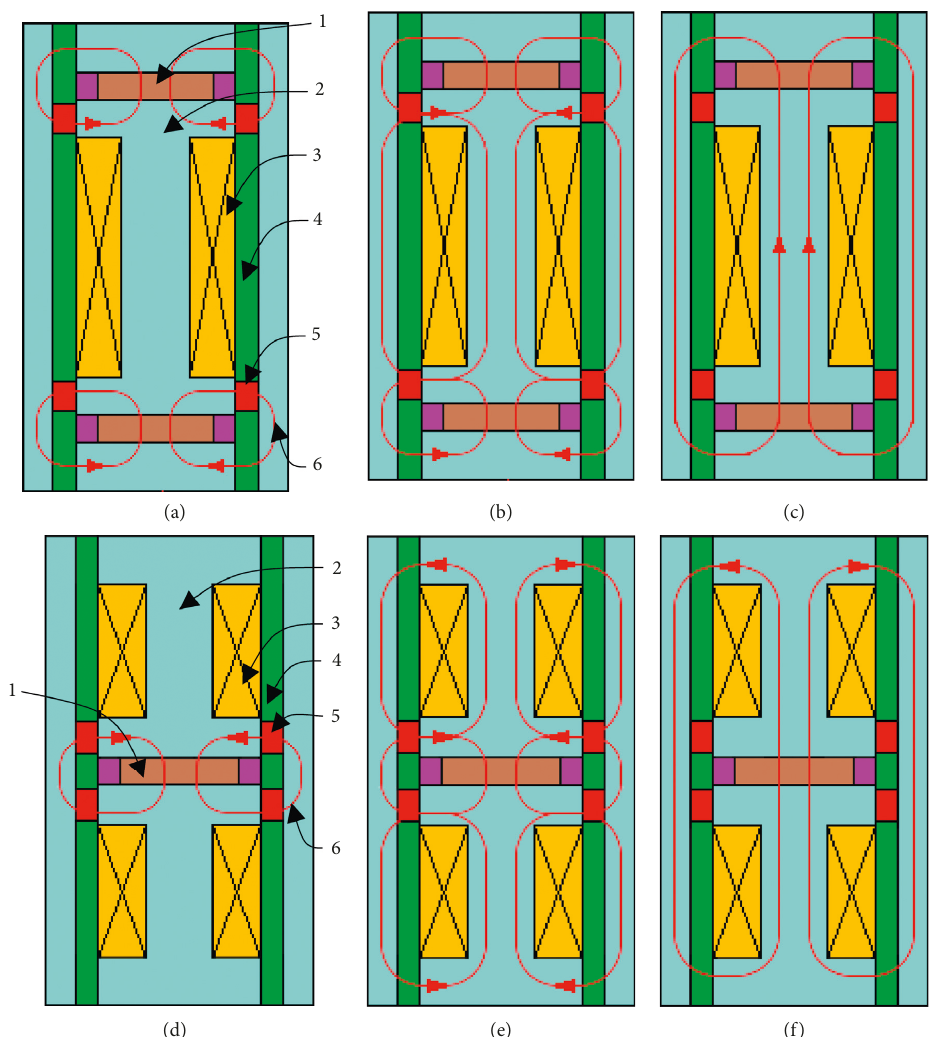
Figure 7: Single-coil and dual-coil fail-safe piston in three different operating modes: without coil current (a, d), with positive coil current (b, e), and with negative coil current (c, f). 1, permanent magnets; 2, core; 3, coil; 4, annular MRF gap; 5, MR valves; 6, magnetic flux lines [32,